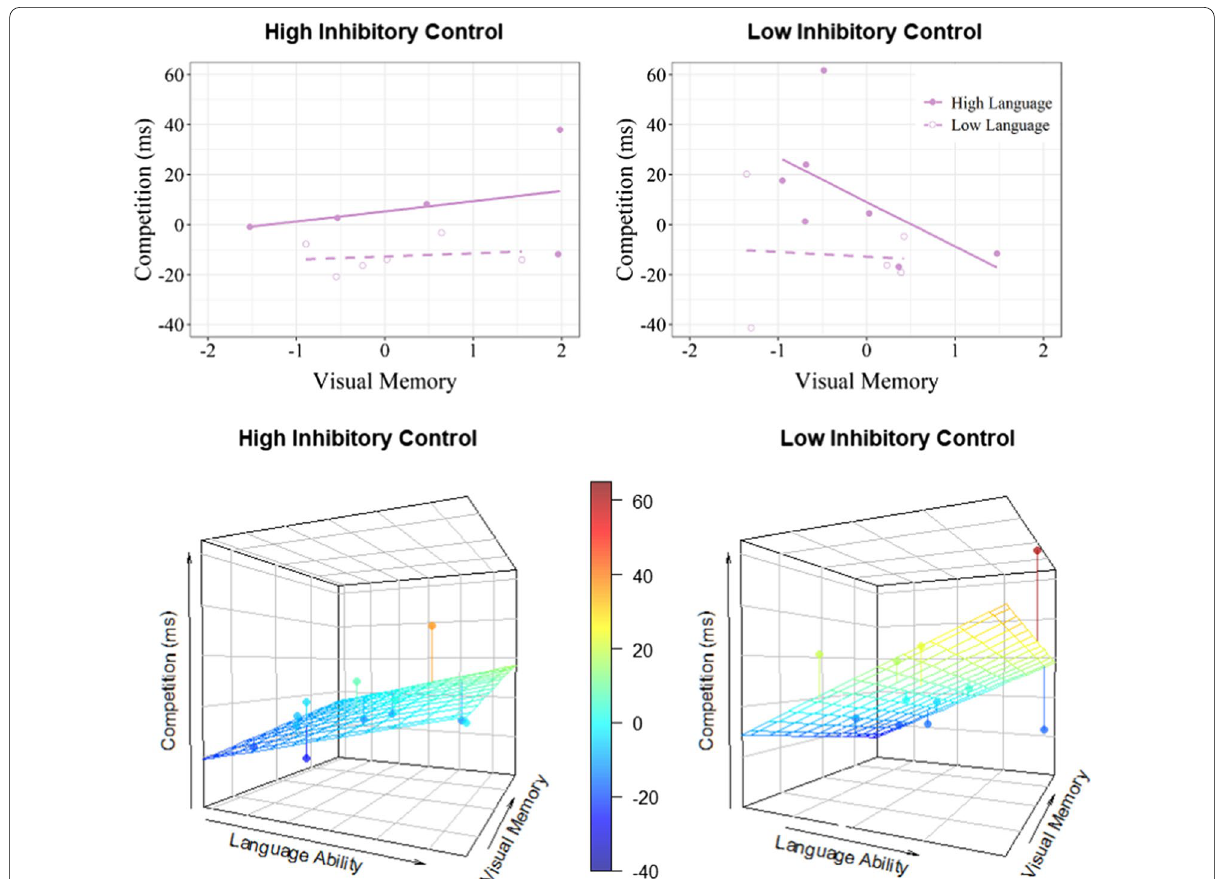
Fig. 4 a Observed relationship between visual memory ( z -score) and the relative duration of competitor fixations (competitor—control) for children with high (left) or low (right) inhibitory control and high (solid) or low (dashed) language ability. Positive values indicate longer looks to competitor than control objects. b Observed (dots) and predicted (grid) relative competition by visual memory and language ability for children with high (left) or low (right) inhibitory control. Redder shades indicate greater competition. Children with better language ability (i.e., larger vocabularies) generally experienced greater phonological competition, especially when combined with lower visual memory and lower inhibitory